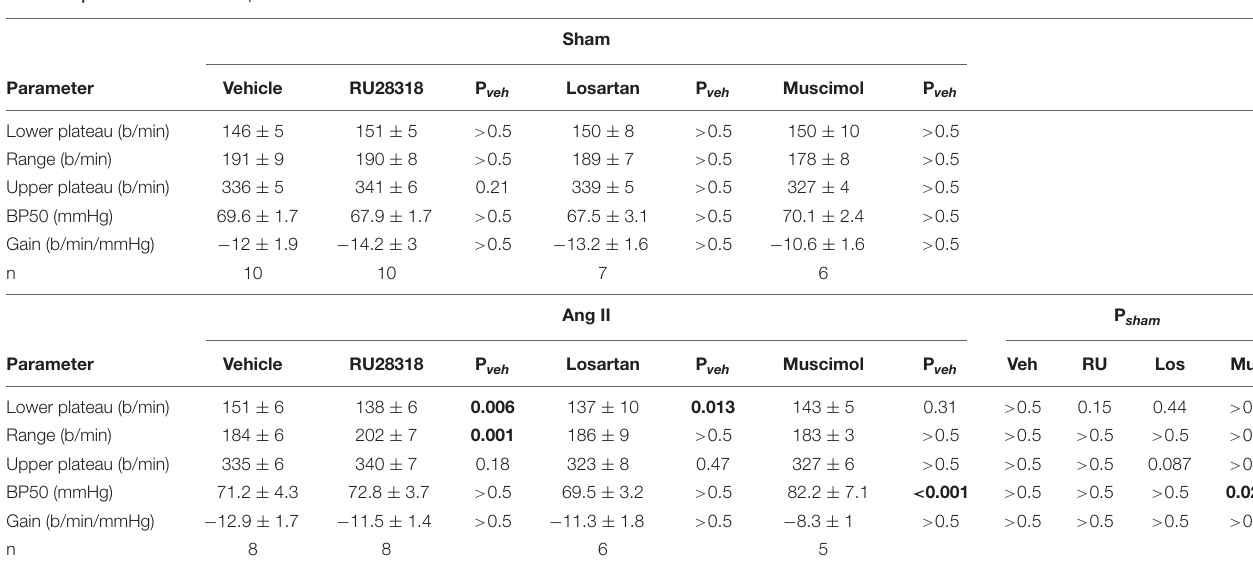
TABLE 3 | Heart rate baroreflex parameters.